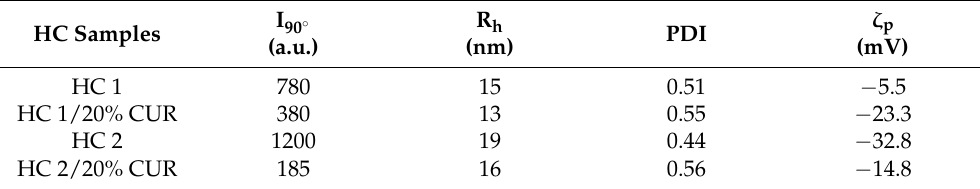
Figure 8. Size distributions from DLS analysis for the neat and CUR loaded NPs of HC 1 ( a ) and HC 2 ( b ). Table 4. Comparison of DLS and ELS results for the neat and CUR loaded